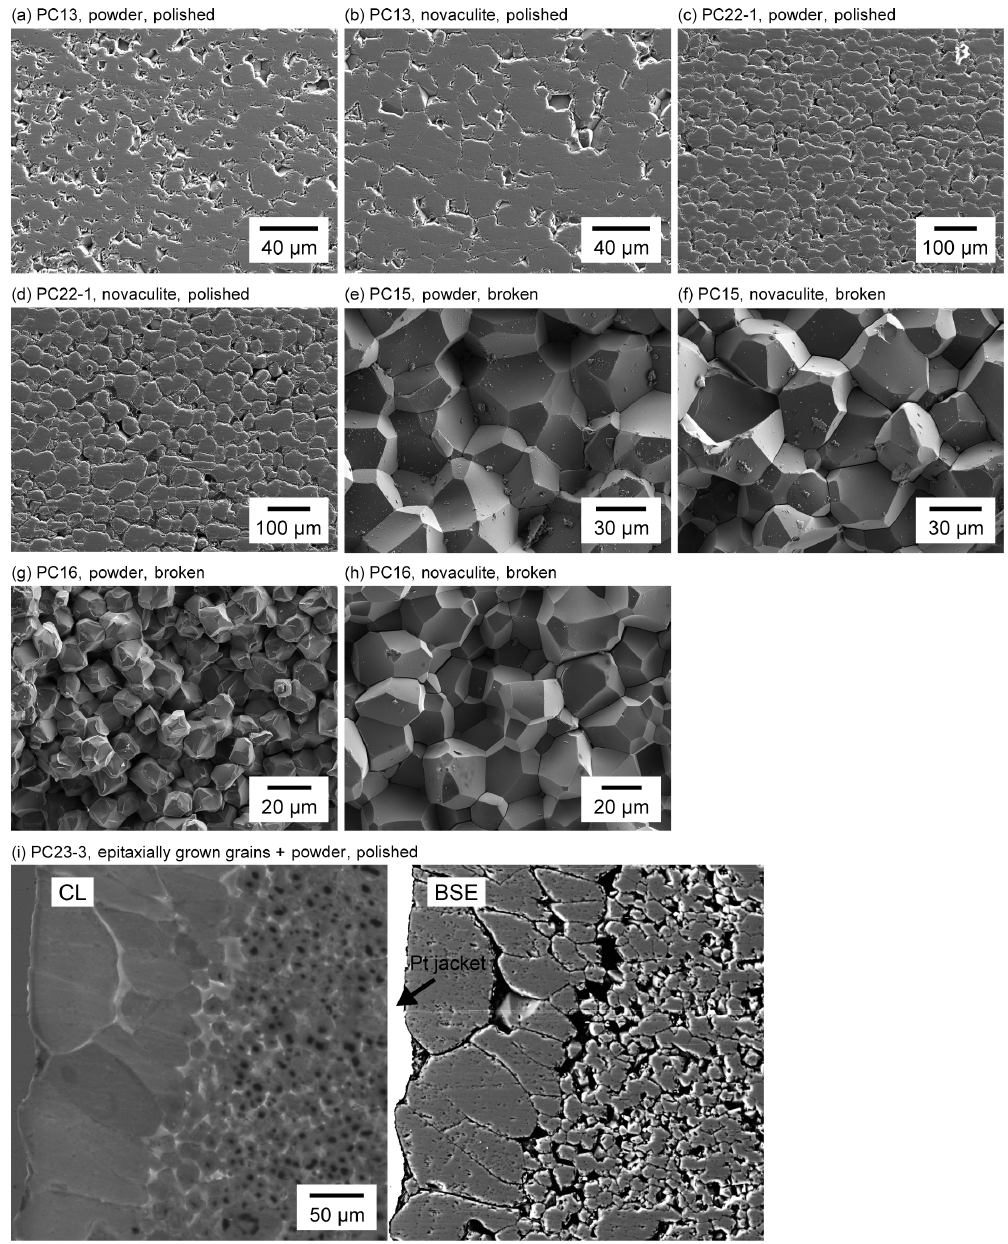
Figure 7. SEM images of samples after experiments. ( a – d ) SE images of polished surfaces. ( e – h ) SE images of broken surfaces. ( i ) CL image (left) and BSE image (right) including a Pt jacket part (labeled in the BSE image) where epitaxial growth was observed (the powder part is on the